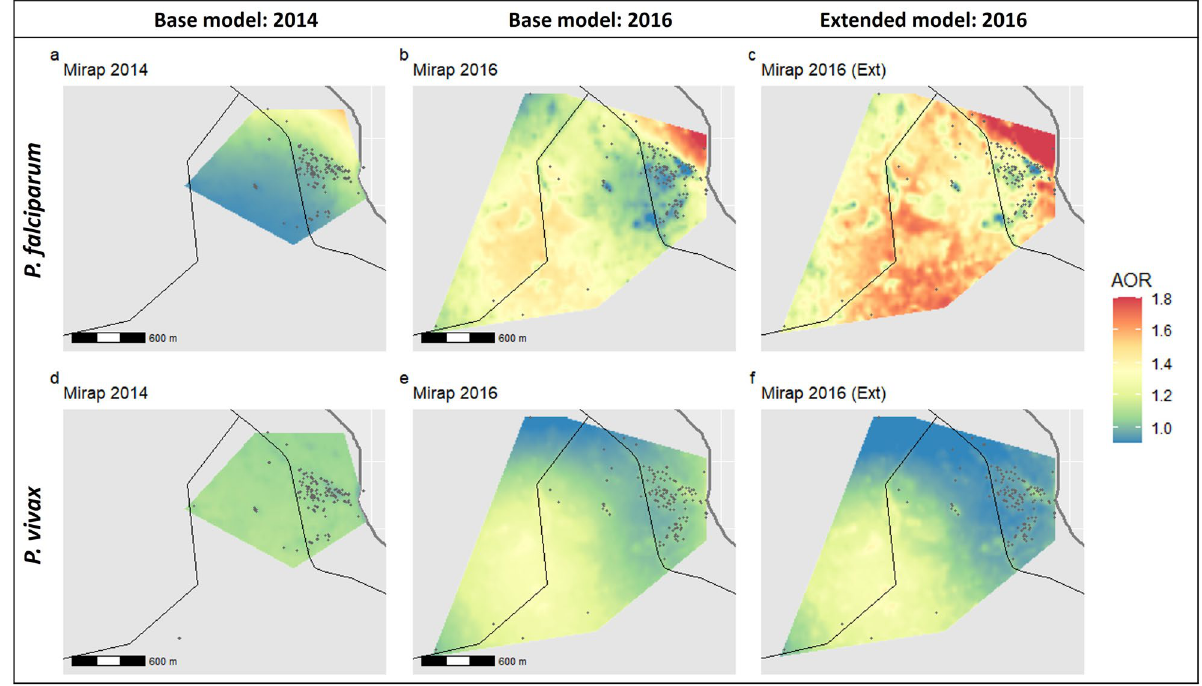
Figure 4. Variable spatial effect of predicted adjusted odds ratios (AOR) for P. falciparum and P. vivax infection derived from generalised additive models (GAM) in Mirap. Base model covariates age, sex, LLIN usage and NDVI were applied in the GAM for 2014 and 2016 ( a , b , d , e ). Base model covariates combined with household covariates (extended model) were applied in the GAM in 2016 ( c , f ) to investigate the contribution of household risk factors to spatial risk. Spatial distribution of sampled households shown in grey points in both the 2014 and 2016 base models. Mirap is a coastal village, thick grey lines represent the coastline and thin black lines represent the main road. Maps were created in R v.3.6.2 (https:// www.R- proje ct.